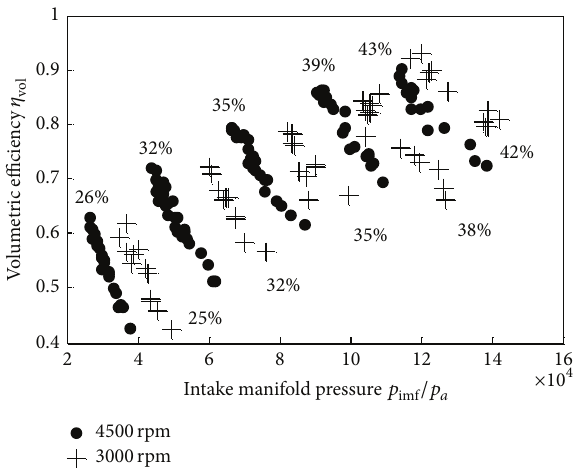
Figure 15: Volumetric efficiency for engine speeds 2000 rpm and 1200